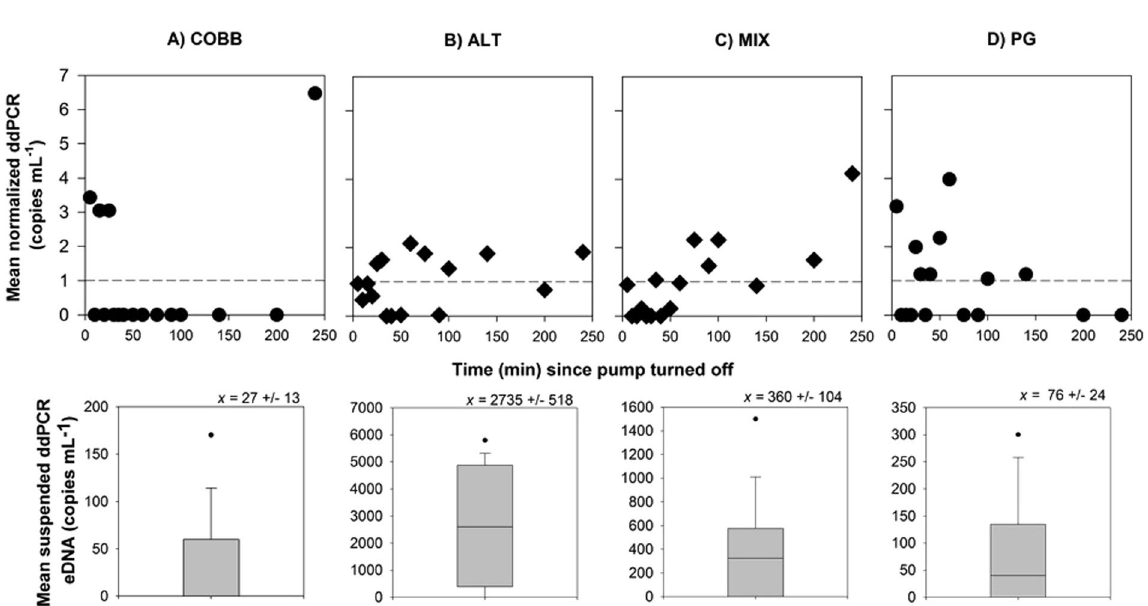
Figure 6. Normalized concentrations over time for COBB ( A ), ALT ( B ), MIX ( C ), and PG ( D ) once pump was turned off at t = 0 (i). All eDNA concentrations are normalized by the mean suspended concentrations in their respective stream to allow between stream comparisons